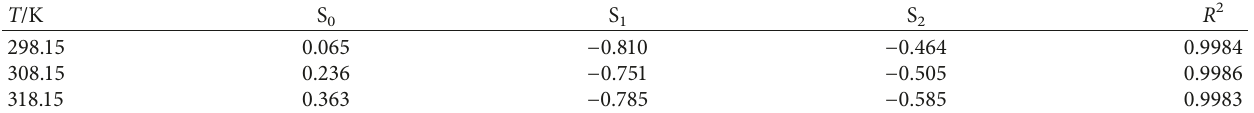
Table 5: Calculated various thermodynamic functions of NaCl dissolved in different mixture ratios of CH x 0 CH 3 OH